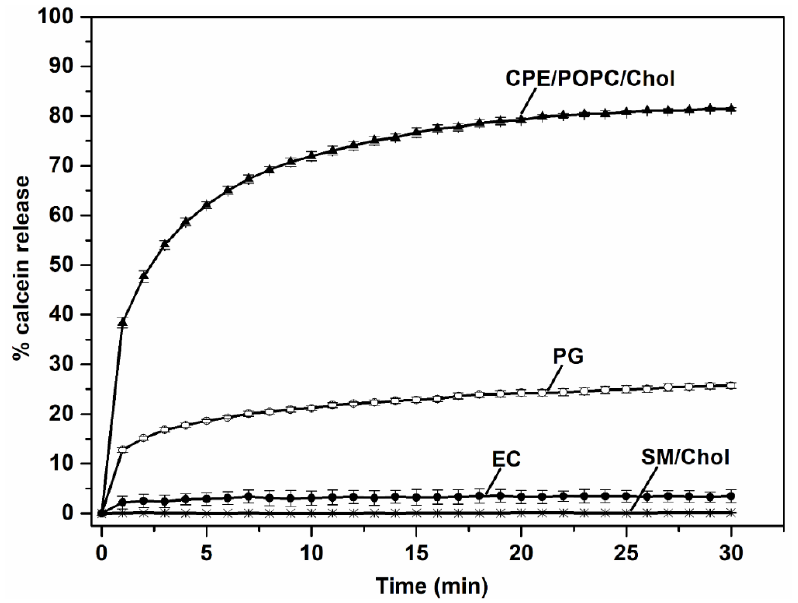
Figure 6. Calcein release from vesicles composed of different lipids. Permeabilization of small unila- mellar vesicles composed of CPE, POPC, Chol (5/47.5/47.5, molar ratio) and SM, Chol (equimolar ratio) and of total lipid extract from E. coli and P. gingivalis . Fluorescence intensity of calcein released from the vesicles was monitored as described in Methods. Data are means ± SE from three indepen- dent experiments. Abbreviations: SM, sphingomyelin; CPE, ceramide phosphoethanolamine;